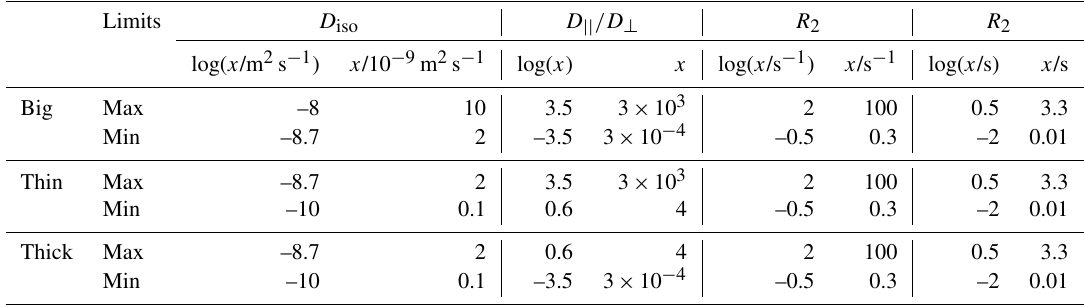
Table 1. R 2 - D limits of the “big”, “thin”, and “thick” bins.